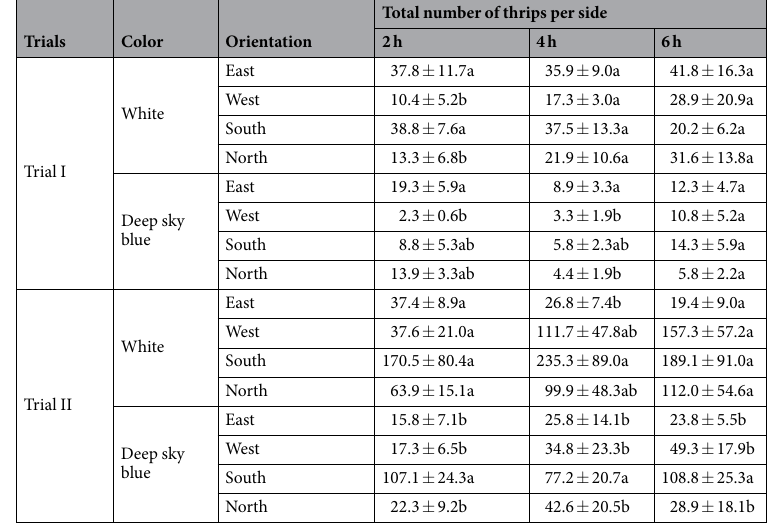
Table 2. The attractiveness of two selected colored cards with different orientations to thrips in trials I and II. (Values are expressed as the mean ± SEM of four replicates, with 6 sides per replicate, P <